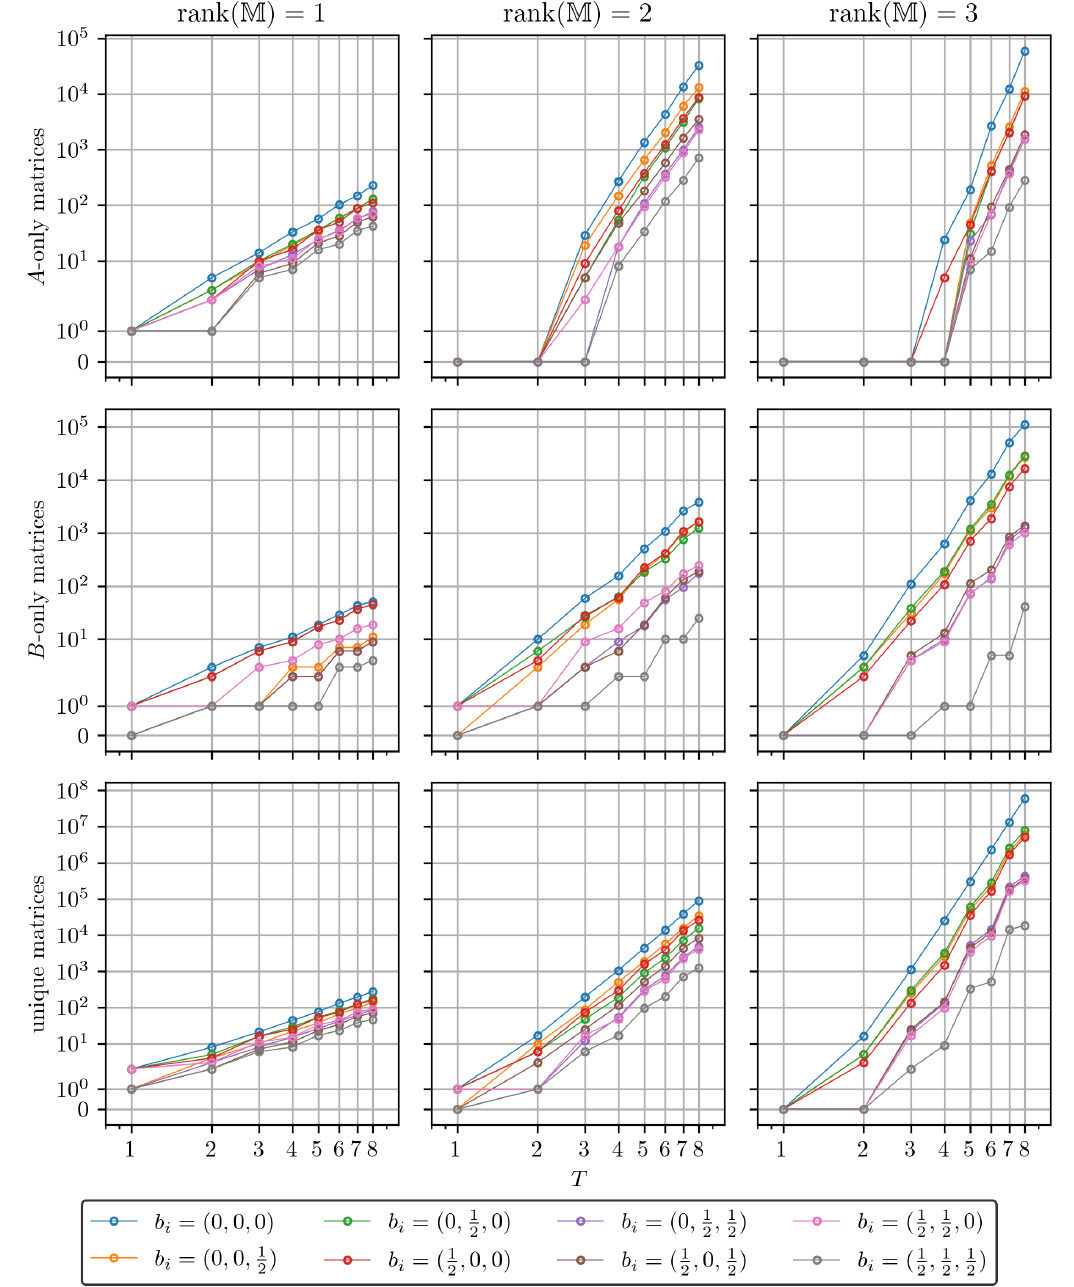
Figure 2. Number of constraint matrices for T ≤ 8 and the eight choices for b i , organized by rank. The first two rows show the number of A -only and B -only matrices while the third row shows the number of unique matrices (see figure 1). The numbers of matrices for the same number of tilted tori are nearly coincident. There is also always the single rank-0 matrix M = 0 configurations with only C